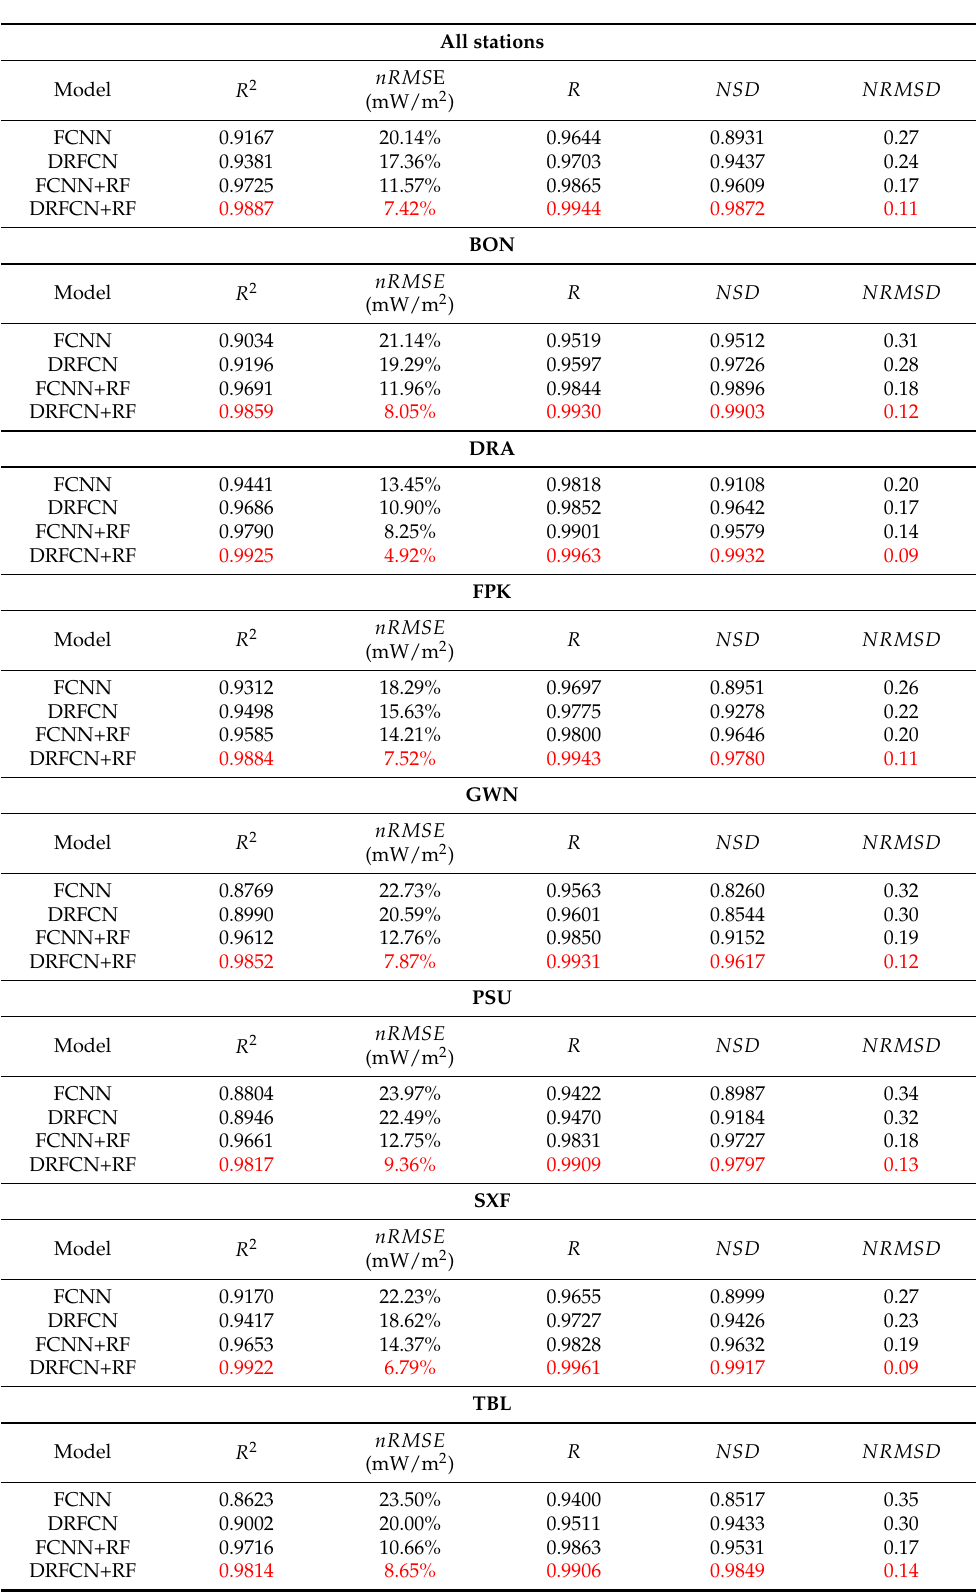
Table 3. Performance evaluation of the DRFCN+RF, DRFCN, fully connected neural network (FCNN), FCNN+RF models by R 2 , nRMSE , coefficient of correlation ( R ), normalized standard deviation ( NSD ), and normalized centered root-mean-square difference ( NRMSD ). The best model is marked in